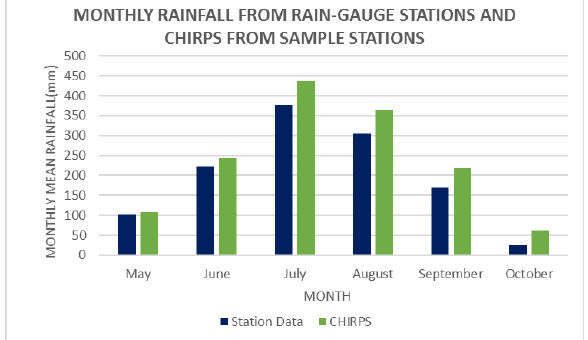
Figure 8. Monthly precipitation of CHIRPS and rain gauges, for all sample